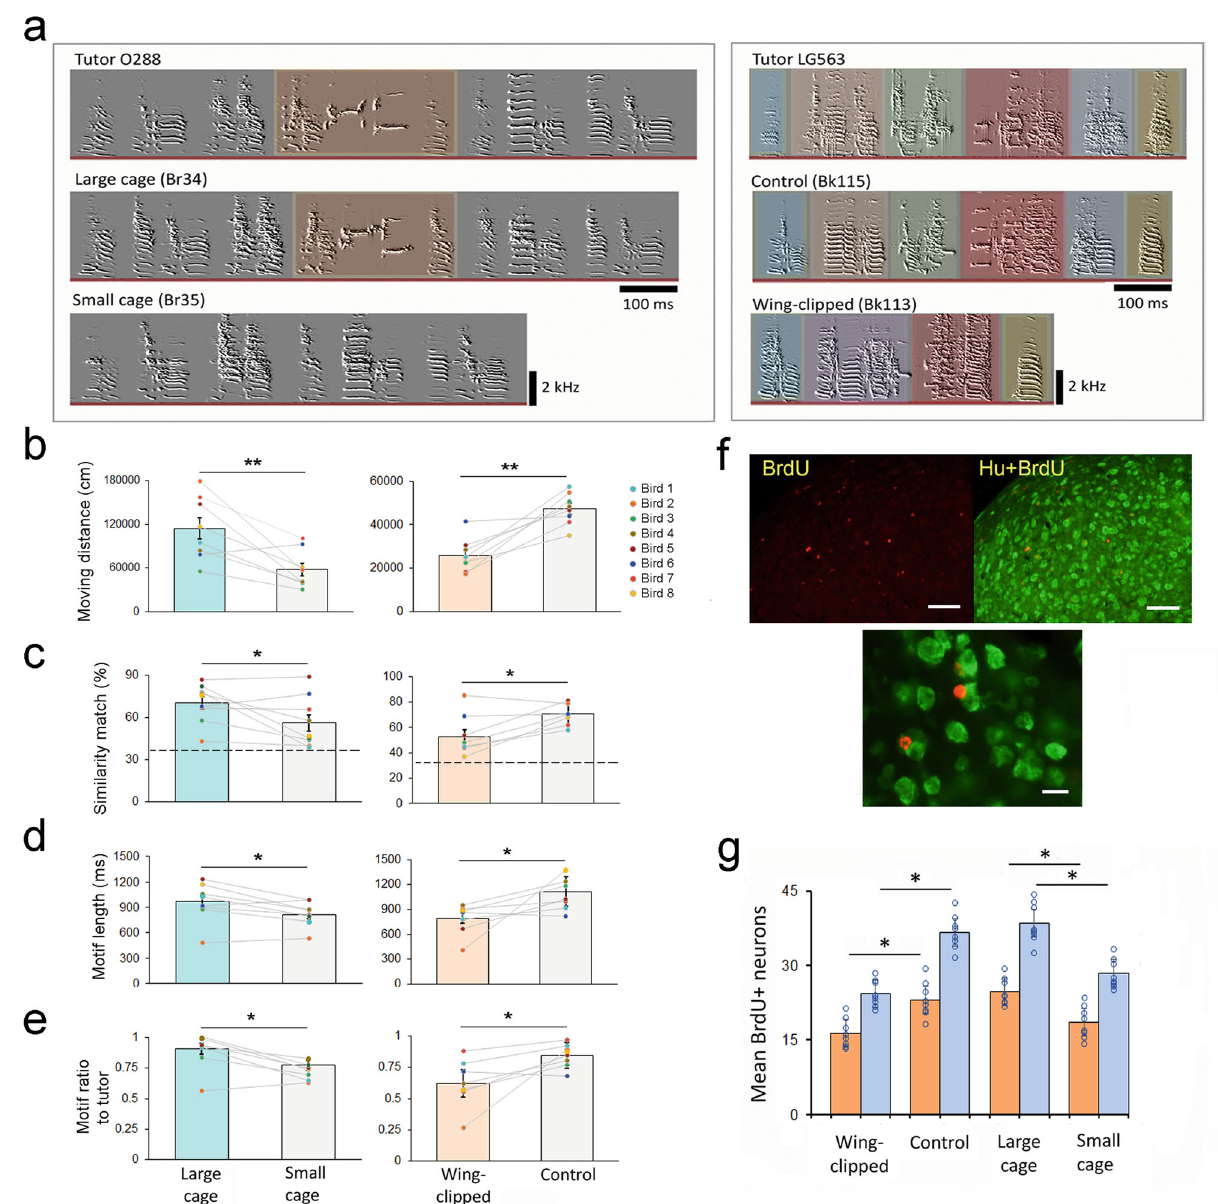
Fig. 4 Manipulation of juvenile locomotor activity affected song learning and neural plasticity. a Sonograms show two family examples of song learning by either promoting locomotion activity with large cage housing, or restricting locomotion with wing clipping or small cage housing, during the sensitive period of song learning between 30 and 65 dph. Left panel. A juvenile kept in a large cage (Br34) had a longer multi-syllable sequence and better tutor imitation (76% match), compared to its sibling that was housed in a small cage (Br35 with 47% similarity match): the highlighted syllable (shown in Tutor 228 and a juvenile Br34) was a complex syllable and was missing in Br35. Right panel, wing-clipped bird (Bk113) had a shorter motif duration and lower similarity match (45%) compared to its tutor ’ s song (LG563) or its intact-control sibling (Bk115; 86% similarity match to tutor song). Similar syllable type between the tutor and the tutees was highlighted with the same color, the wing-clipped bird (Bk113) produced fewer syllables and syllables were less similar to its tutor, compared to its sibling (Bk115). b – e Birds housed in a large cage (green bar, n = 8) had signi fi cantly more movement ( b ), better song imitation ( c ), longer song motif ( d ), and longer motif duration ratio relative to the tutor song ( e ) compared to their siblings (light gray bar, n = 8) that were housed in a small cage (** P < 0.01, * P < 0.05). Similarly, wing-clipped birds (orange bar, n = 8) had signi fi cantly less moving distance, less similarity match to tutor song, and shorter motif length than their intact-control siblings ( b – e ), n = 8 birds; from 5 adult tutors). Each colored dot in a graph bar depicts an individual bird, and the gray line connects two sibling birds from the same clutch. The dashed lines in ( c ) represent the average similarity score between adult tutors ( n = 8) and unrelated juveniles ( n = 15) from other families. f BrdU-labeled neurons in a song nucleus HVC. Red: BrdU-labeled cells, Green: Hu- labeled neurons. Scale bar = 50 µ m on the top images and 10 µ m on the bottom image. g Juveniles housed in a smaller cage ( n = 8 birds) and wing-clipped birds ( n = 8 birds) had fewer BrdU-labeled neurons in two forebrain song nuclei (HVC and Area X, light orange and light blue bars respectively; error bars depict the mean and standard error of the number of BrdU + neurons) compared to the birds housed in a larger cage and intact-control birds. Each dot represents an individual